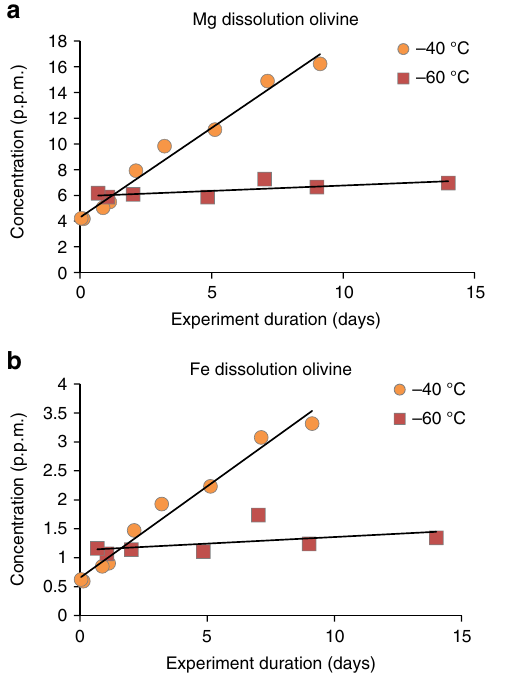
Fig. 2 Measurements of a Mg 2+ and b Fe 2+ concentrations in solutions after experiments were concluded. Linear best fi t lines are shown for clarity although weathering rates were only calculated using longest duration experiments ( > 3 days). The R 2 for the linear fi ts are 0.98 for the experiments at − 40 °C. The R 2 values for linear fi t of the − 60 °C are not as good 0.53 for Mg 2+ and 0.22 for Fe 2+ as these experiments were closer to the blank values. Atomic absorption measurements were performed in